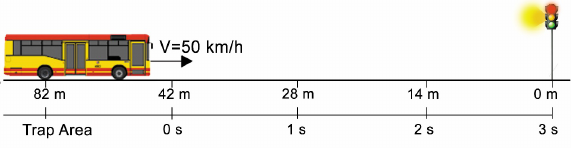
Table 1: Data for calculating the stopping distance when permissible